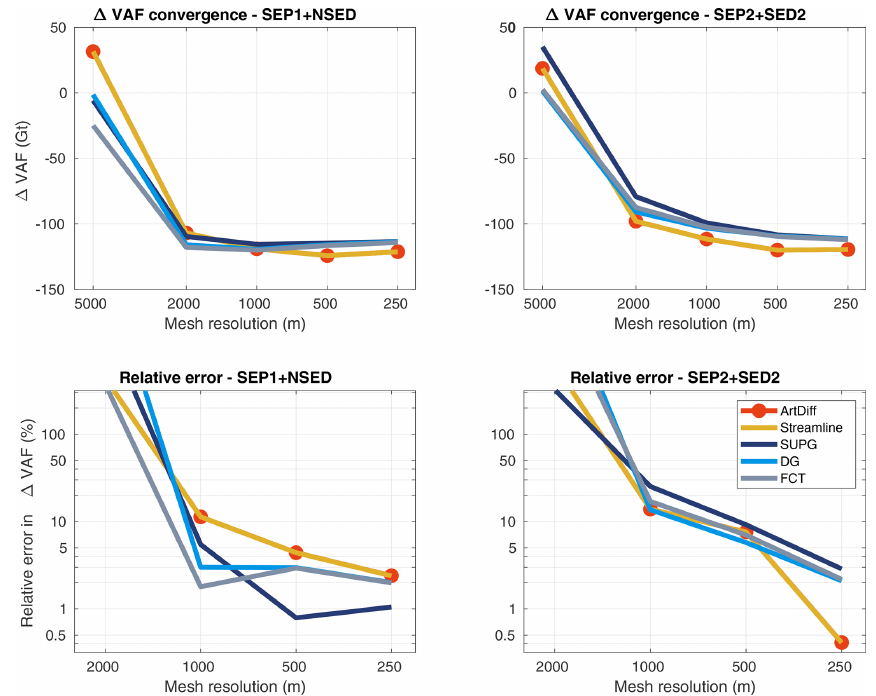
Figure 6. No external forcing experiment: convergence of (cid:49) VAF at the end of the experiment ( t = 100 years) for different stabilization schemes (see legend). Two sets of parameterizations are employed: SEP1 + NSED (left panels) and SEP2 + SED2 (right panels). The relative errors are computed using Eq.